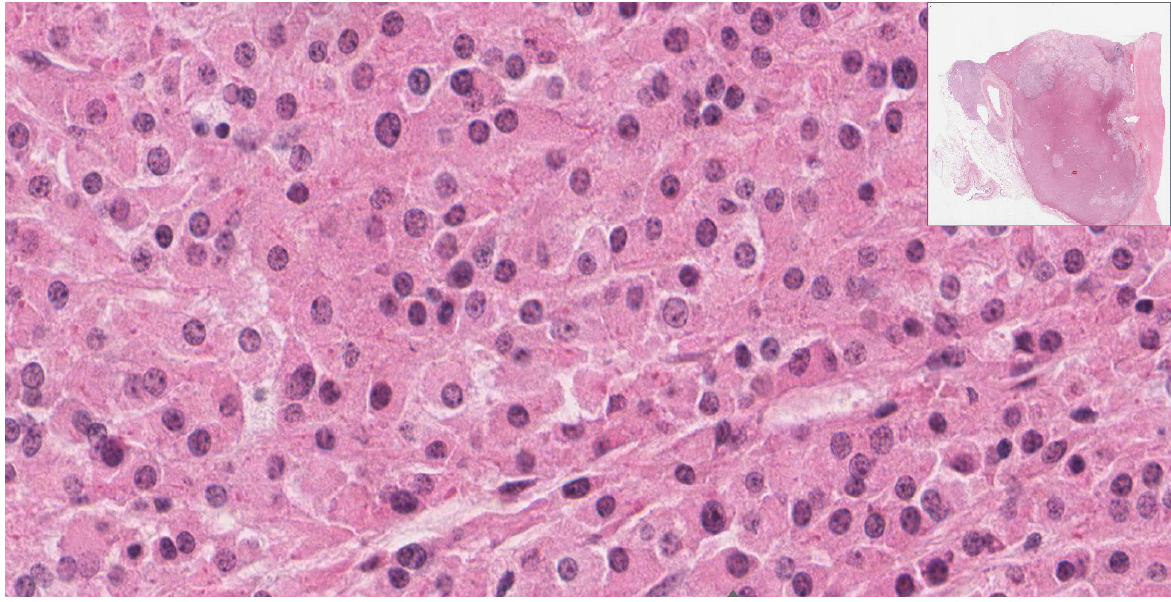
Figure 3. (40 × ): Carcinoma component: epithelioid cells with abundant cytoplasm and round